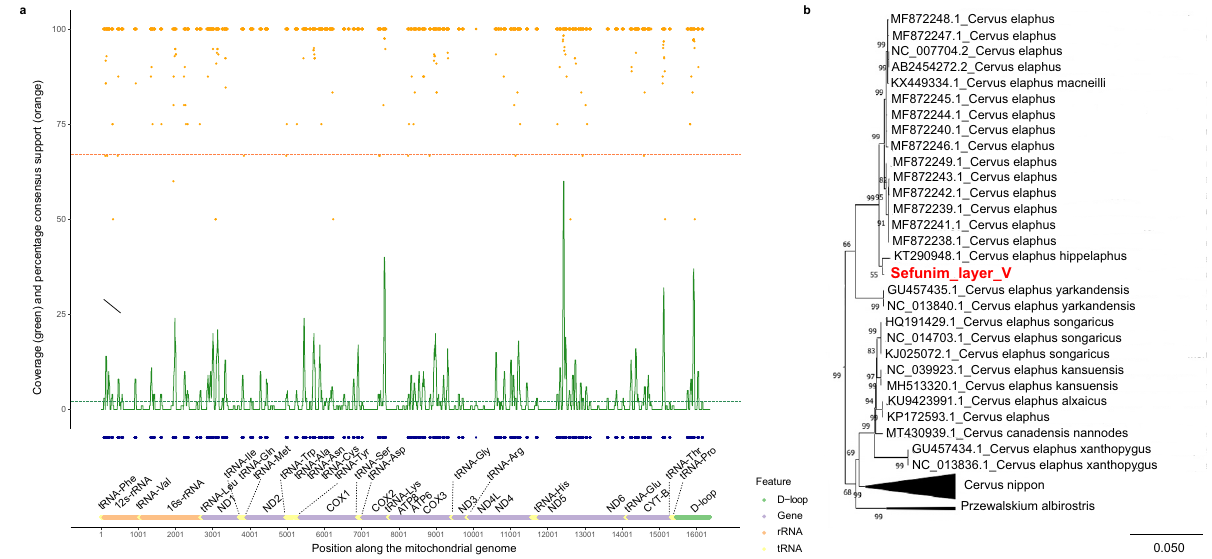
Figure 6. Placing the DNA from Layer V within the Cervidae mtDNA diversity. ( a ) Reconstruction of a partial consensus mtDNA genome sequence, using the alignment to the Cervus elaphus reference mitochondrial genome (bottom). Blue dots indicate the positions at which bases could be called (middle). At each position, the coverage (green) and the support for the majority base (orange) is shown (top). The minimum thresholds for these parameters are shown in dashed lines. ( b ) Maximum Likelihood phylogenetic tree based on the partial mtDNA genome sequence reconstructed from sample SP5773 (shown in red) and 380 previously-sequenced Cervidae mtDNA genomes. Branch lengths are scaled based on the number of substitutions per site, and the support for each branch is based on 500 bootstrap replications. Only the part of the tree containing the Sefunim sample is shown, with the full tree presented in Supplementary Fig. S2. The phylogenetic tree was plotted in MEGA X 84 (https:// www. megas oftwa re.